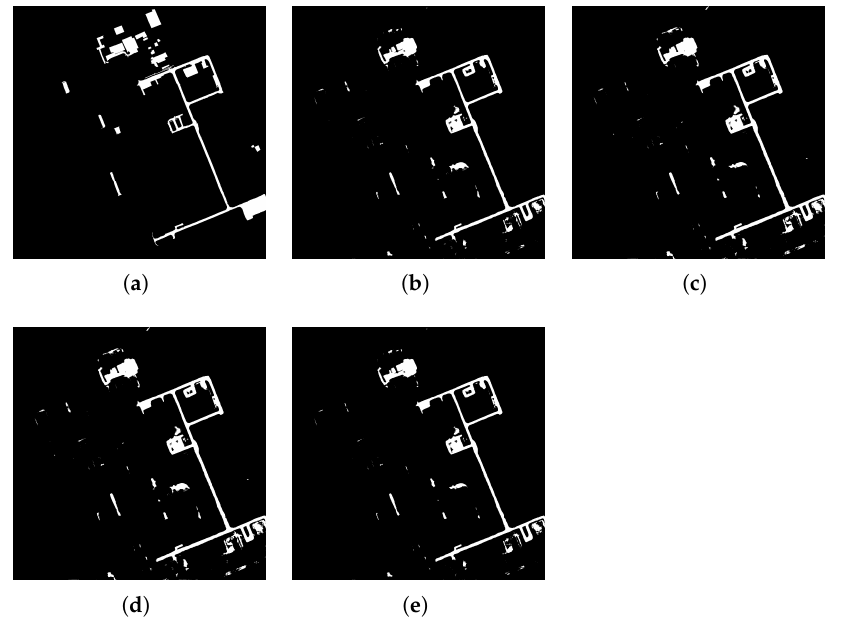
Figure 11. The results of the four methods of fusion. ( a ) Ground truth. ( b ) The result of the vector cosine similarity comparison. ( c ) The result of the vector difference similarity comparison. ( d ) The result of the OR gate operation. ( e ) The result of the AND gate